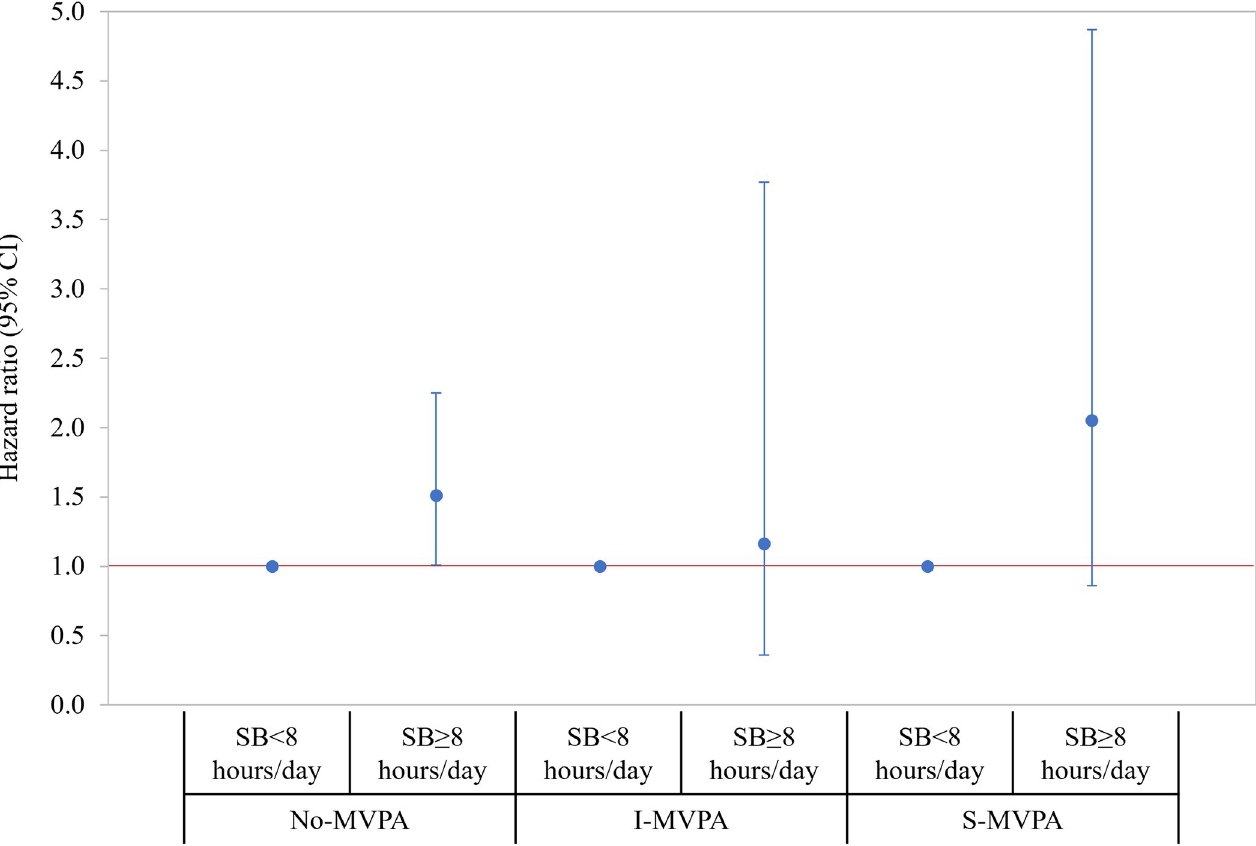
Fig 3. Stratified associations by MVPA level where HF patients with SB < 8 hours/day were a reference group within each stratum. Hazard ratios (95% CI) were estimated from the Cox proportional hazard regression model adjusting the study covariates retained using the backward elimination approach ( P < .20), as described in Fig 1 . The estimated parameters presented in the figures are reported in Online Supplemental Table 6 in S1 File . CI = confidence interval; SB = sedentary behavior; I-MVPA = insufficient moderate-vigorous-intensity physical activity (MVPA minute/week between 0 and 150); S-MVPA = sufficient moderate- and vigorous-intensity physical activity ( � 150 minutes/week of